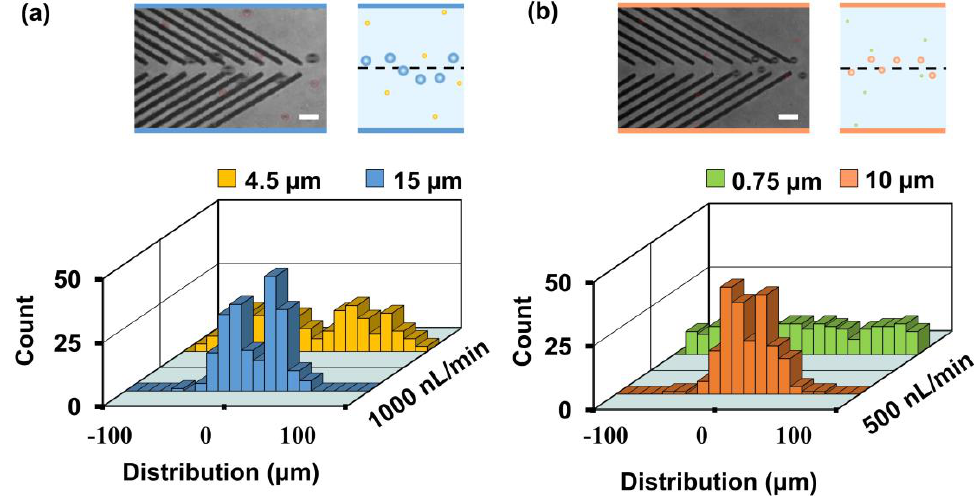
Figure 7. Selective particle focusing enabled by open v-shaped microstructures. ( a ) Distributions of 4.5- and 15- μm polystyrene particles at the end of the third block (outlet). The injection flow rate is 1000 nL/min. ( b ) Distributions of 0.75- and 10- μm polystyrene particles at the outlet. The injection flow rate is 500 nL/min. Red circles denote the positions of the 4.5- and 0.75- μm particles. Two hundred particles are measured for each group. Superimposed experimental images and schematics are shown. Scale bar is 30 μm.